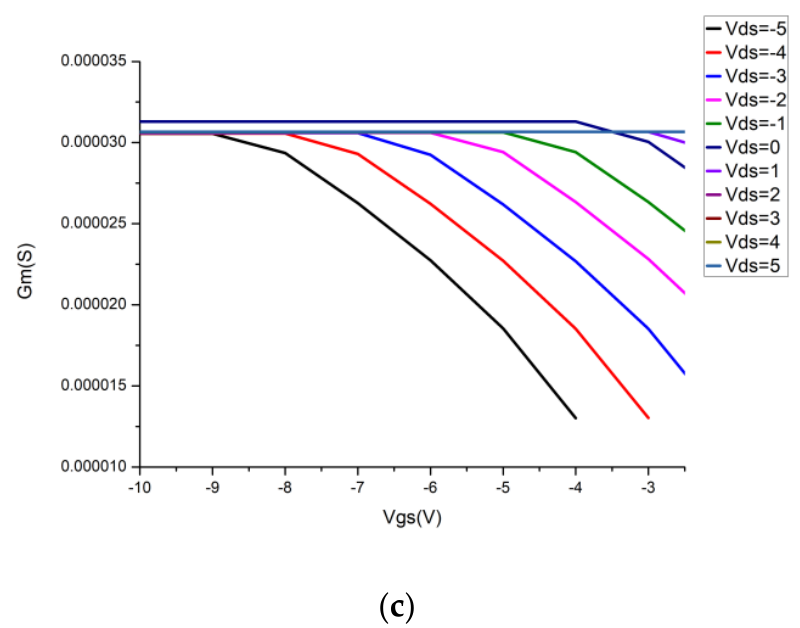
Figure 4. ( a ) I ds -V ds and ( b ) I ds -V gs curves of ion sensitive GO-Si based metal-semiconductor junction resistor gas sensor. ( c ) Transconductance of back-gate (g m ) of different V ds.